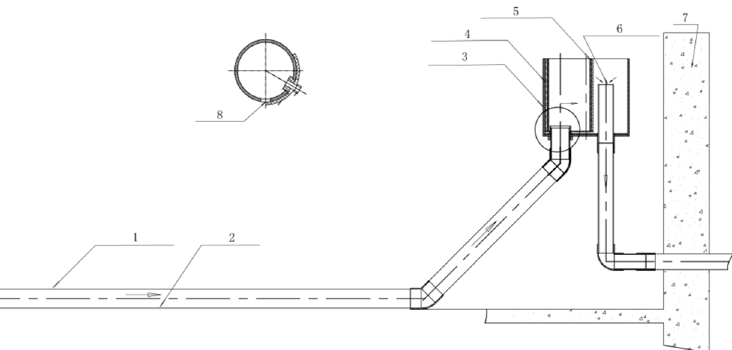
Figure 2. Device for the removal of shrimp shells, dead individuals, and sewage. (1) Sewage col- lection pipe; (2) long strip sewage collection opening; (3) backwater drainage tank; (4) live shrimp anti-escape frame; (5) anti-escape net; (6) fixed water level pipe; (7) tank wall; (8) gap in sewage collection opening with adjustable size.